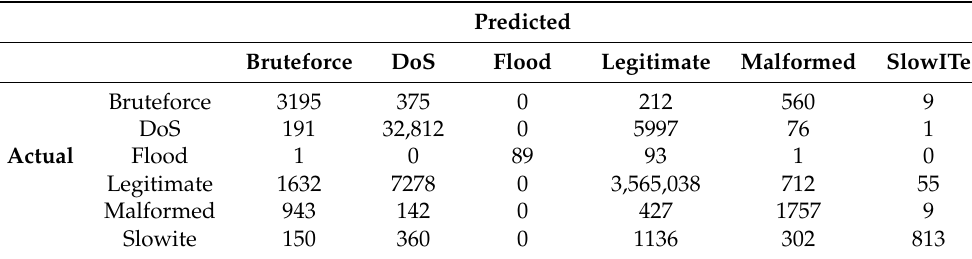
Table 7. Confusion matrix random forest.